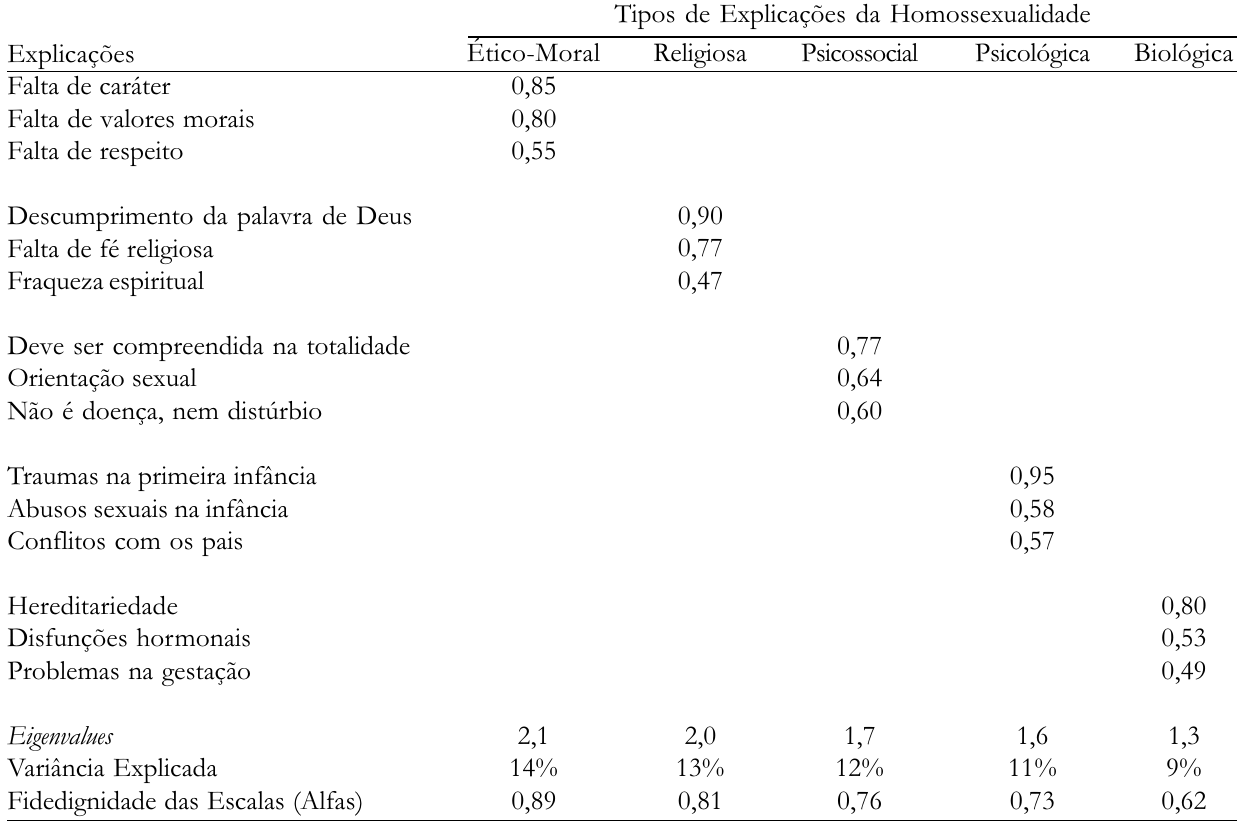
Tabela 3. Cargas Fatoriais, Eigenvalues, Vari(cid:226)ncia Explicada e Fidedignidade das Escalas de Explica(cid:231)ıes da Homossexualidade